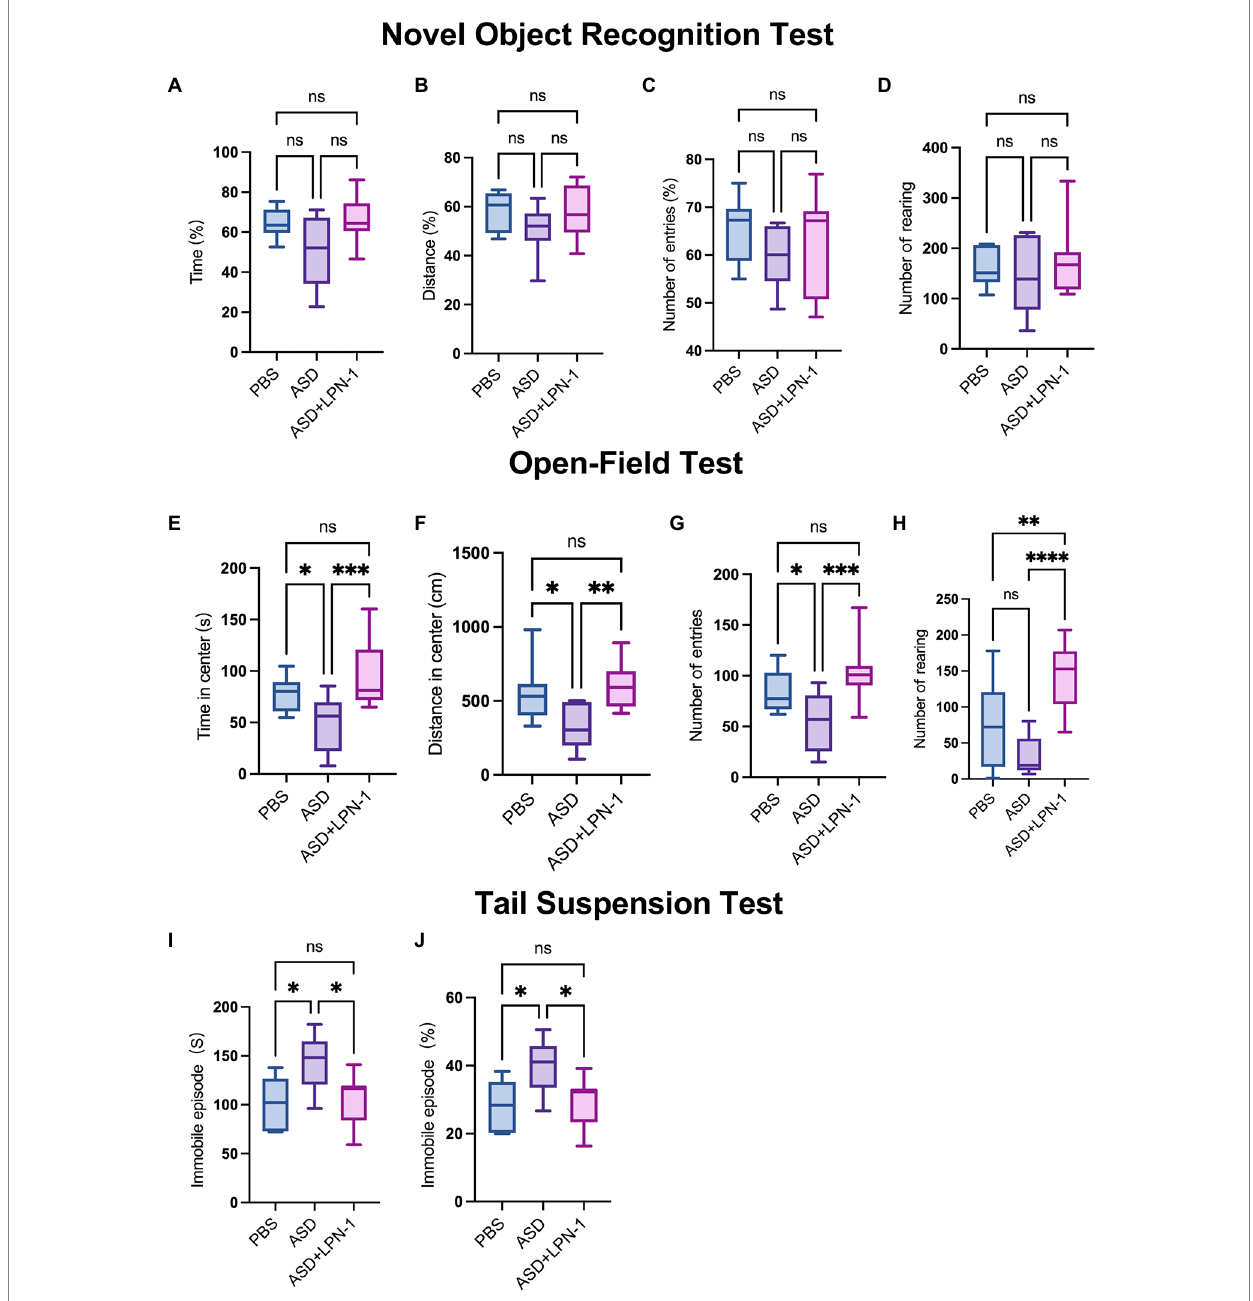
FIGURE 3 (1) Novel object recognition test, phosphate-buffered saline (PBS) ( n = 6), autism spectrum disorder (ASD) ( n = 6), ASD + LPN-1 ( n = 8). Experimental schedule showing the different phases of the NOR familiarization (10 min), and test (5 min). Discrimination index of time spent around the novel object (A) and the distance (B) or the number of entries (C) . Total number of rearing (D) . (2) Open-field test, PBS ( n = 12), ASD ( n = 9), ASD + LPN-1 ( n = 12). Time spent in center (E) . Distance traveled in the center (F) . Number of entries (G) . Number of rearing (H) . (3) Tail suspension test, PBS ( n = 6), ASD ( n = 6), ASD + LPN-1 ( n = 11). Graphs show the total time spent immobile (I) and the proportion of immobility time (J) . * p < 0.05, ** p < 0.01, *** p < 0.001, **** p <